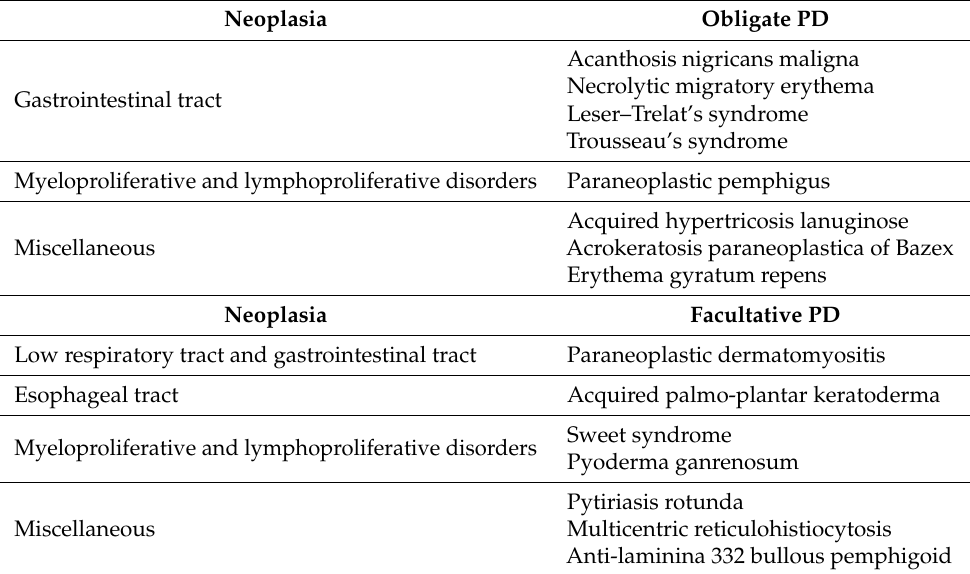
Table 3. Obligate and facultative paraneoplastic dermatoses